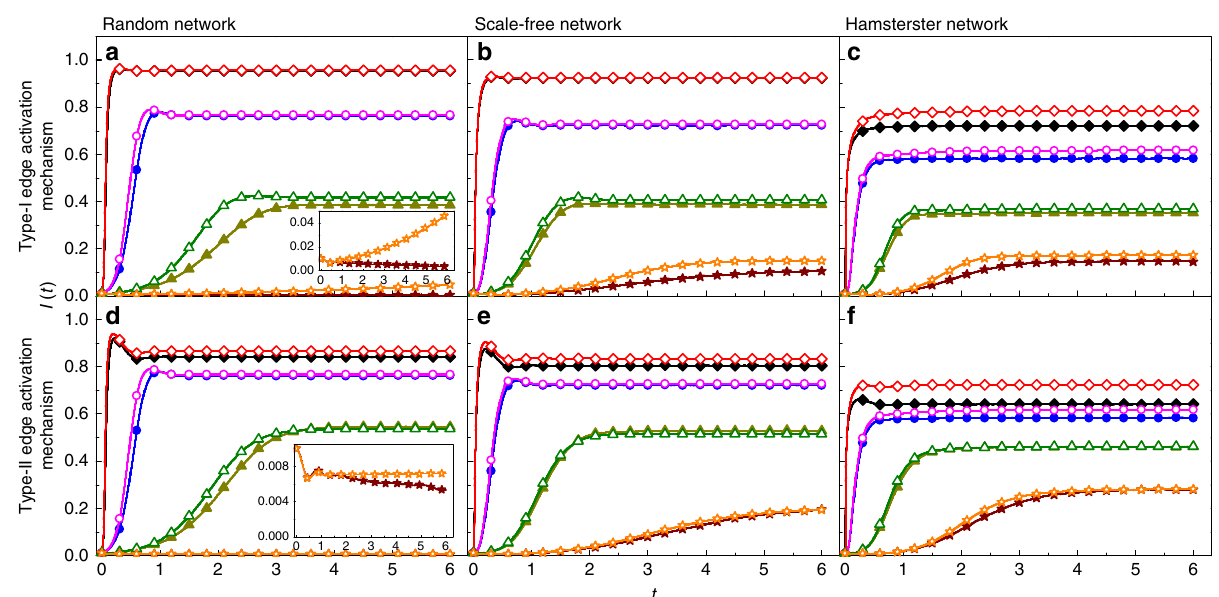
R R P N þ1 þ1 ω ð τ Þ I ð τ ; t Þ d τ and S ð τ ; t Þ a Φ ð τ ; t Þ d τ , respectively. c Each block i i ij i j rec 0 0 j ¼ 1 R þ1 ω ð τ Þ I ð τ ; t Þ d τ i rec 0